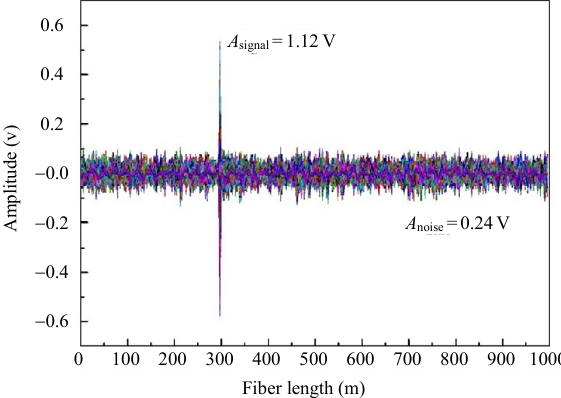
Fig. 10 Location information without average in our proposed system by using the